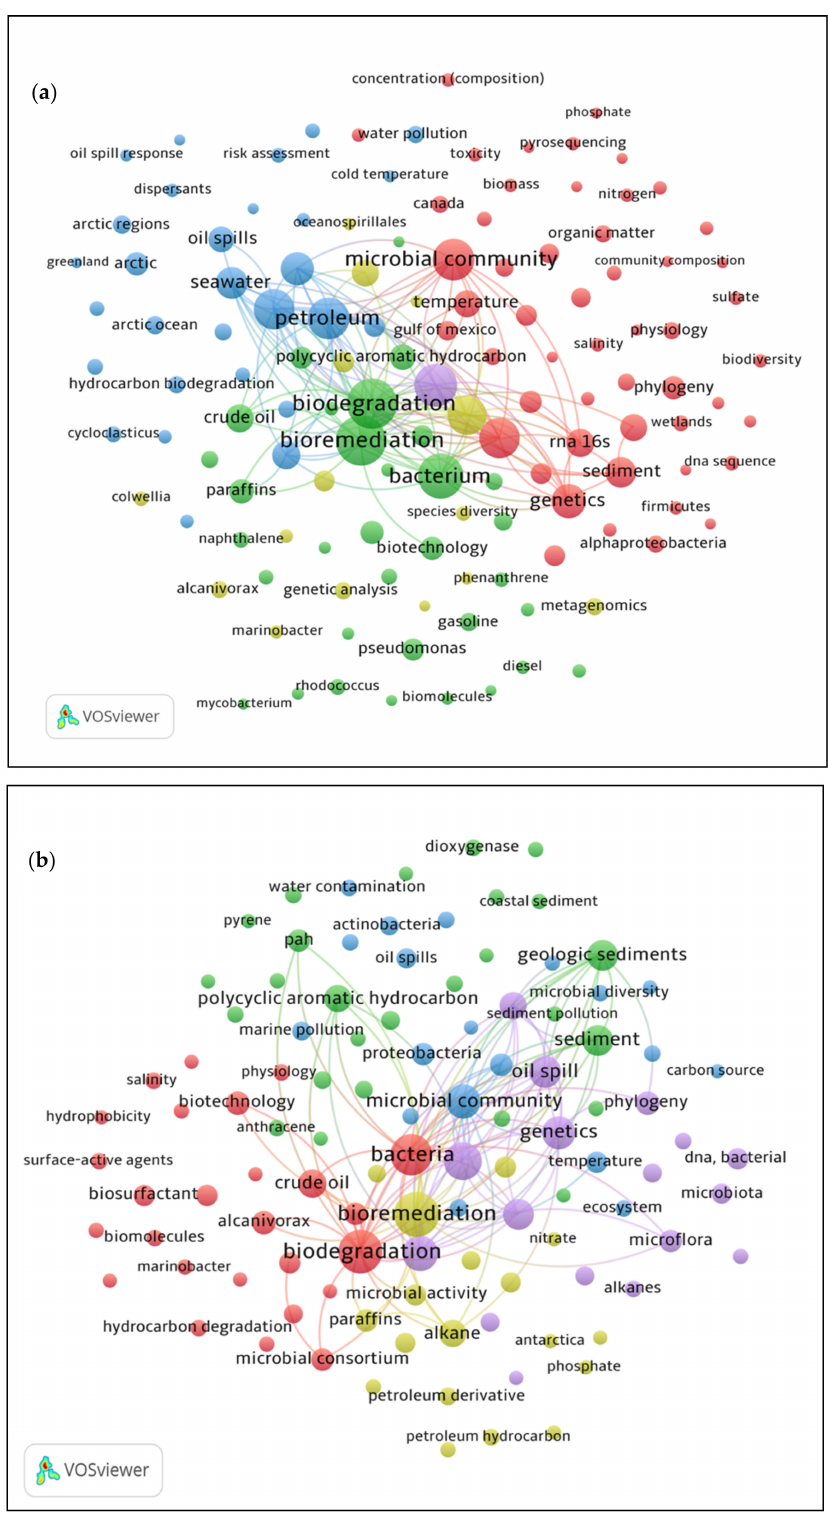
Figure 2. Keywords occurrence on hydrocarbon degradation by ( a ) Arctic and ( b ) Antarctic marine microbial